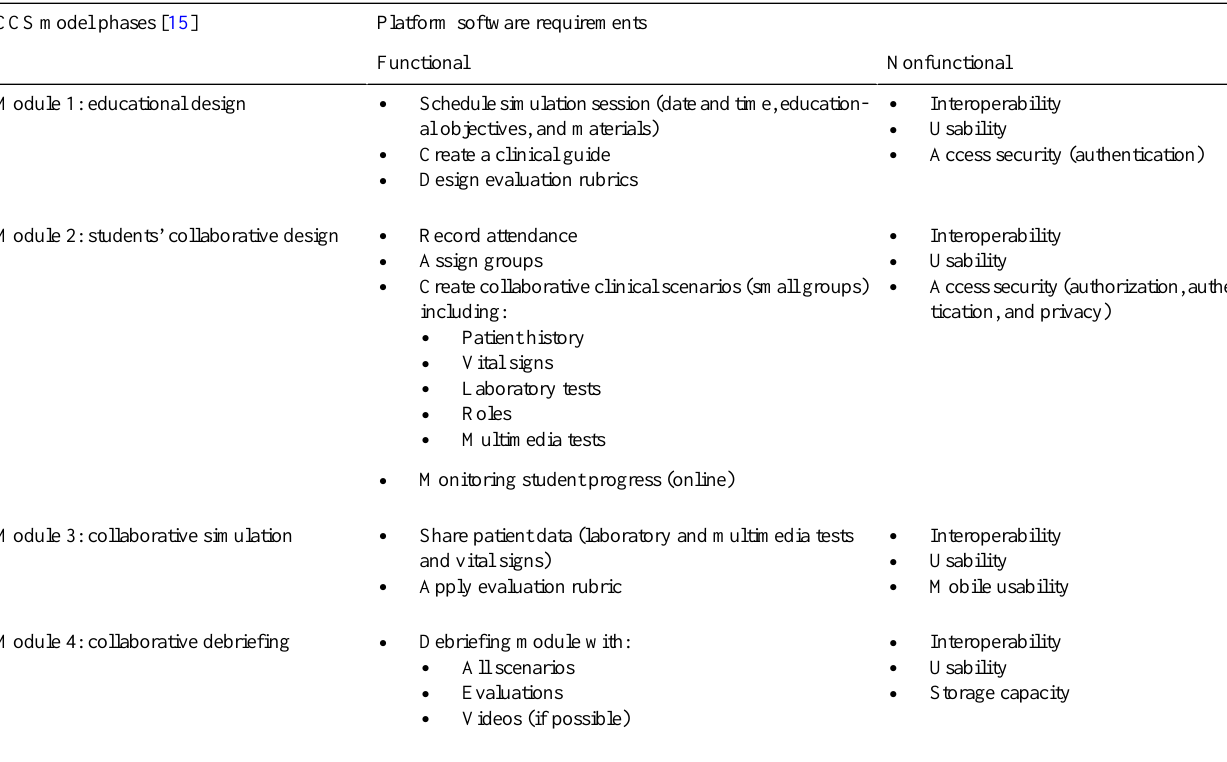
Table 1. Results of functional and nonfunctional requirements to design and develop the web platform MOSAICO for the collaborative clinical simulation (CCS) model. Functional requirements were obtained from Guinez-Molinos et al